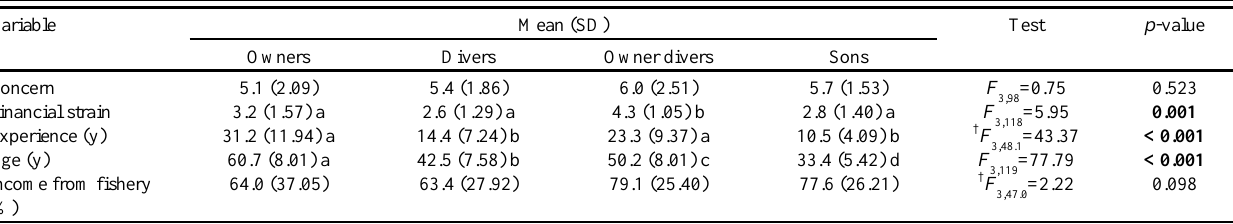
Table 3 . Comparison of predictor variables hypothesized to influence stakeholders’ opinions about the optimal total allowable commercial catch (TACC). Significant tests are highlighted in bold ( a = 0.05). Letters next to values indicate differences between groups of stakeholders; those that share the same letter are not significantly different from each other ( a = 0.05, post-hoc Ryan’s